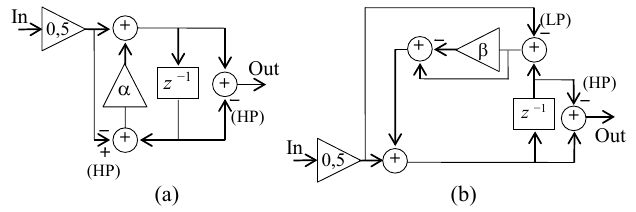
Fig. 3. Bilinear real sections: (a) MHNS -based; (b) LS 11-based [25]. in this publication. Both are universal real digital filters,